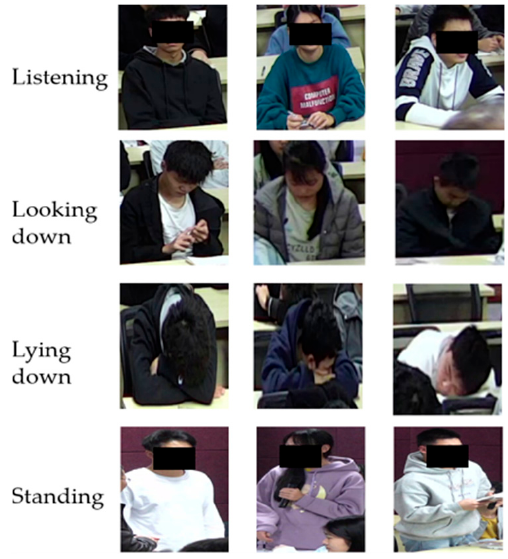
Figure 12. Some samples of this